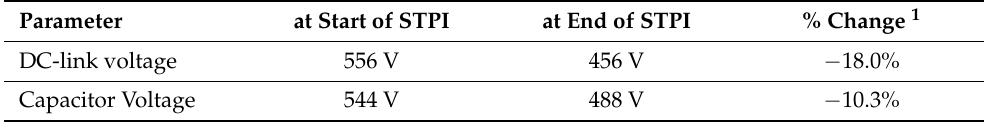
Table 4. Impact on speed and motor torque.